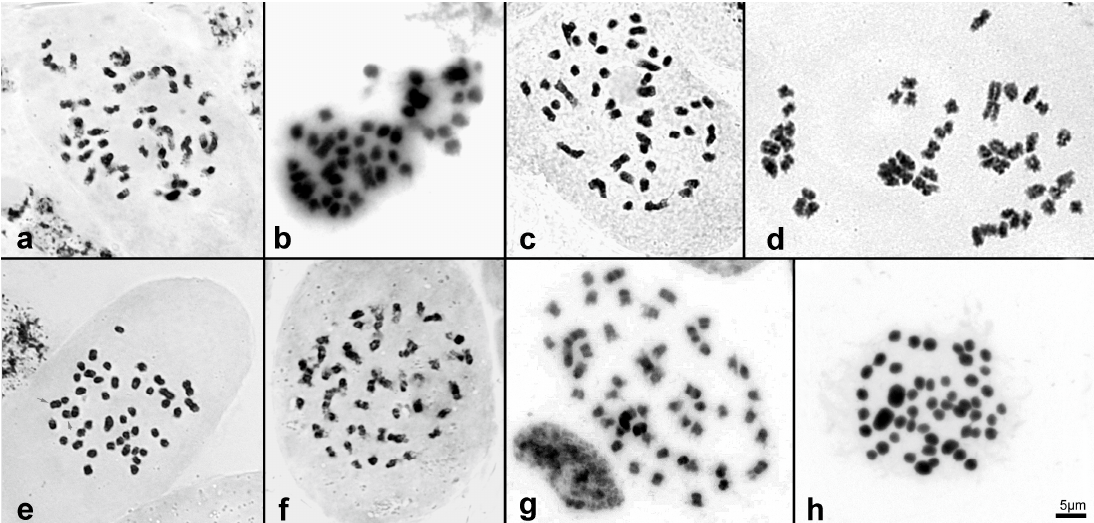
Figure 3. Chromosome complement of Brasolia and Elleanthus species. ( a ) B. altissima (2 n = 46), ( b ) B. cattleya (2 n = 42), ( c ) B. dichotoma (2 n = 46), ( d ) B. flava (2 n = 46), ( e ) B. hirtzii (2 n = 44), ( f ) B. portillae (2 n = 48), ( g ) E. brasiliensis (2 n = 50), ( h ) E. crinipes (2 n = 50). Bar in h correspond to 5 µm.